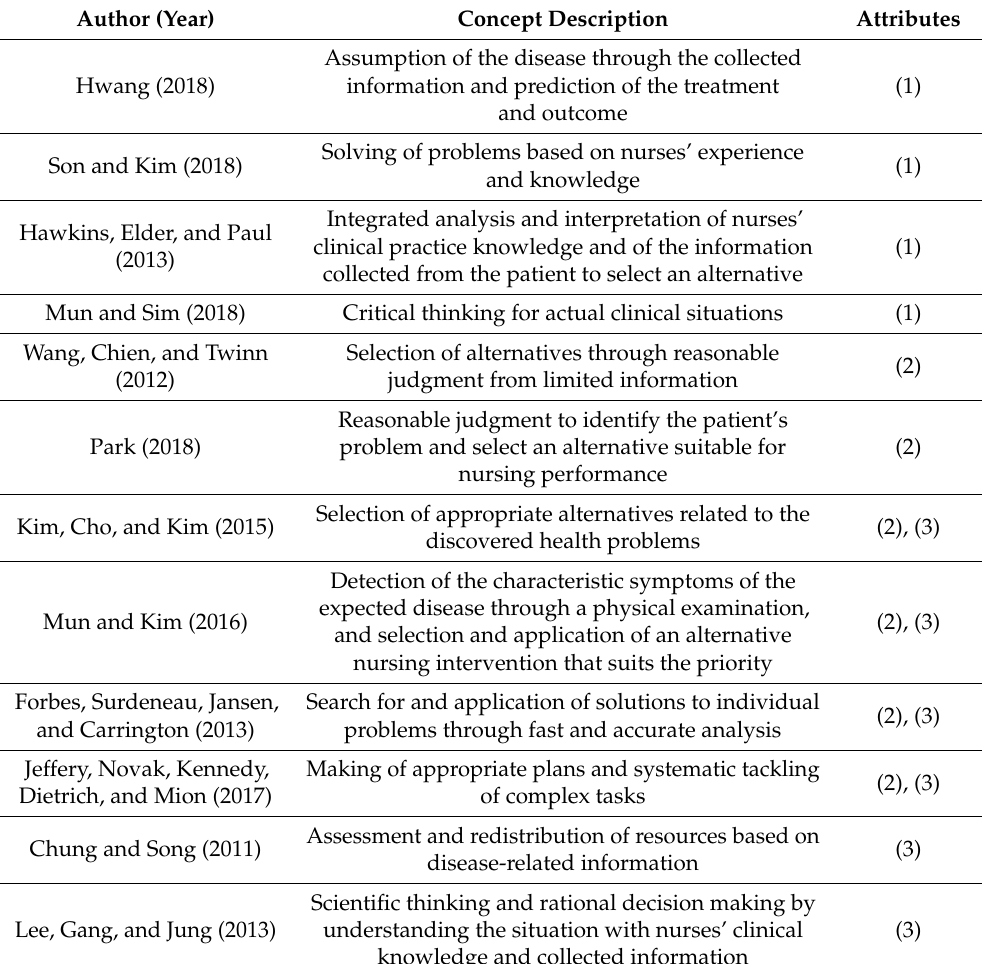
Table 1. Attributes of clinical decision